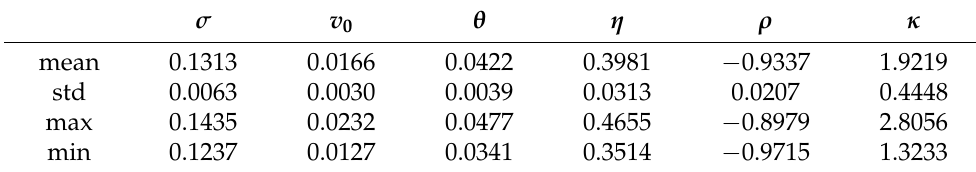
Table 1. Pre-calibration summary for initial